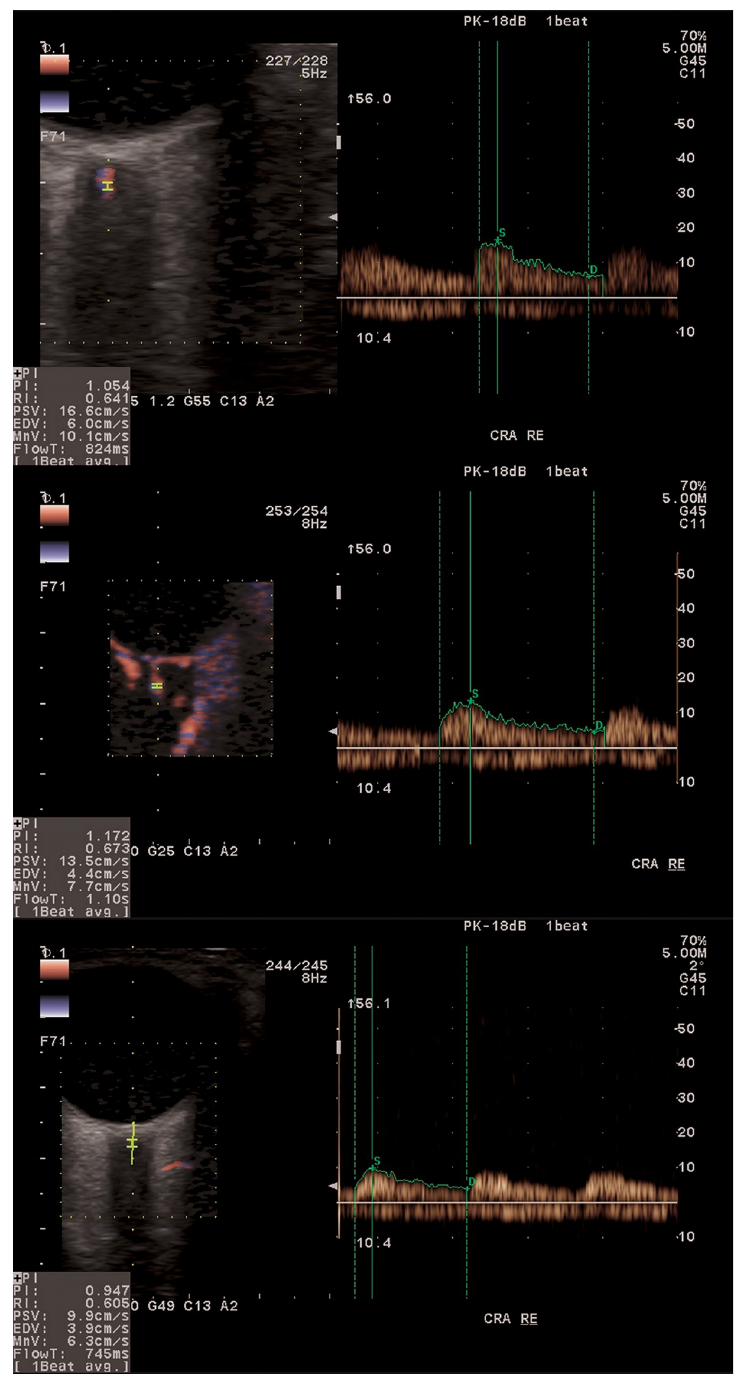
Fig 1. An example of ocular blood flow in CRA for the three considered groups of subjects. From top to bottom: healthy control, normotensive glaucoma suspect, glaucoma